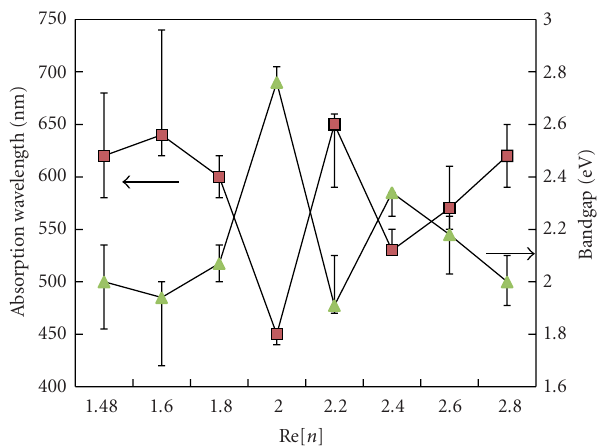
Figure 4: The absorption wavelengths and bandgaps versus the real part of the refractive index are summarized here after their identifications from the figures such as Figure 3 for a homogeneous microsphere. The points are the exact locations of wavelength for the strongest fluctuations while the vertical bars represent a range where fluctuations are seen.